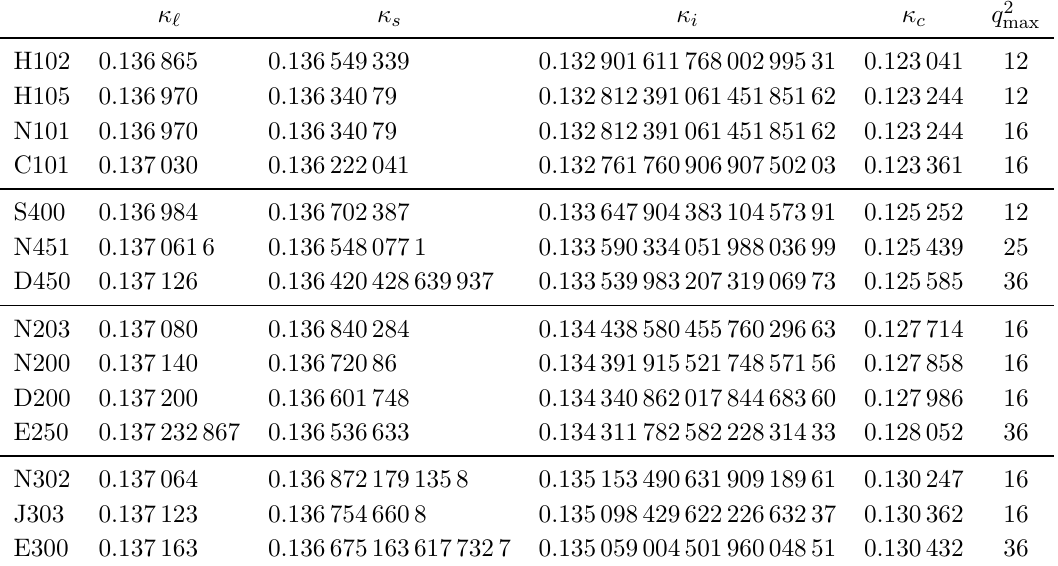
Table 11 . Values of (valence) κ ‘,s,i,c for the ensembles for which disconnected loops have been produced, together with the lattice momentum cutoff q 2 in units of (2 p /L ) 2 up to which momentum max space data has been saved for both local and one-link displaced